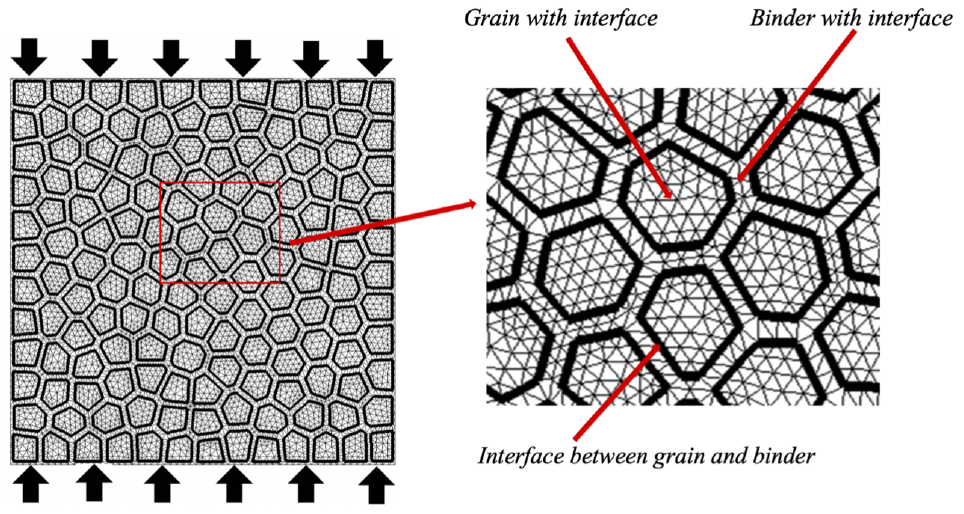
Figure 1. Geometric model with interface and boundary conditions.